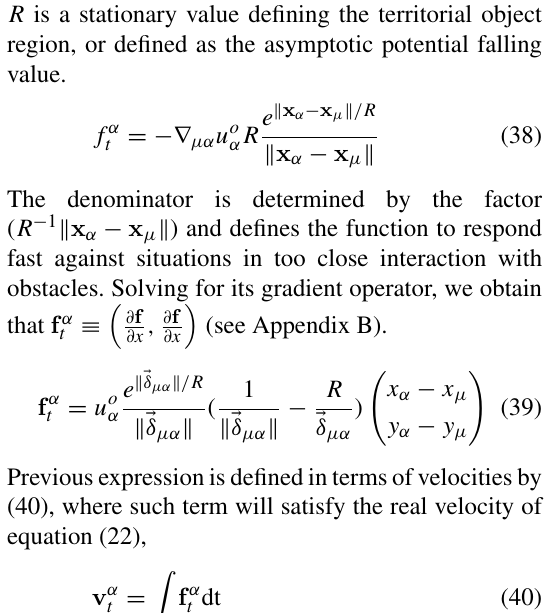
Table 6 Algorithm New robot’s desired bearing